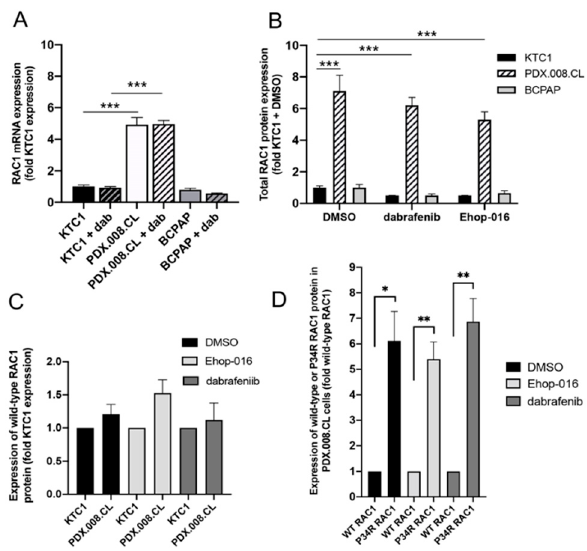
Figure 3. RAC1 mRNA and protein expression/activity in PDX.008.CL cells in comparison to other thyroid cancer cell lines. ( A ) RAC1 total mRNA expression in the PDX.008.CL cell population was 5-fold that of KTC1 and BCPAP cells ( n = 3, *** = p < 0.005). ( B ) RAC1 total protein expression in the PDX.008.CL cells was about 5–7-fold that of KTC1 and BCPAP cells. RAC1 protein expression was not altered by dabrafenib nor EHop-016, an inhibitor of RAC1 activity ( n = 3, *** = p < 0.005). ( C ) The level of expression of wild-type RAC1 protein in PDX.008.CL cells was not significantly different from that in KTC1 cells ( n = 4, p = 0.19). ( D ) In PDX.008.CL cells the level of expression of RAC1 (P34R) protein was 6-fold that of wild-type RAC1, and was not altered by dabrafenib nor EHop-016, a specific inhibitor of RAC1 activity ( n = 5, * = p < 0.05, **= p < 0.005).